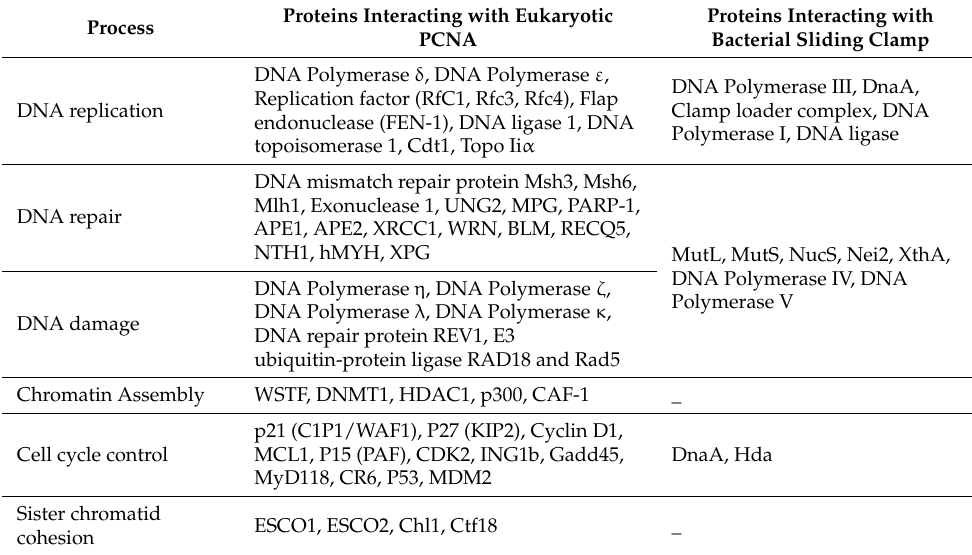
Table 1. Sliding clamp-binding proteins. Table shows the list of various cellular processes and the proteins that interact with the sliding clamp during these